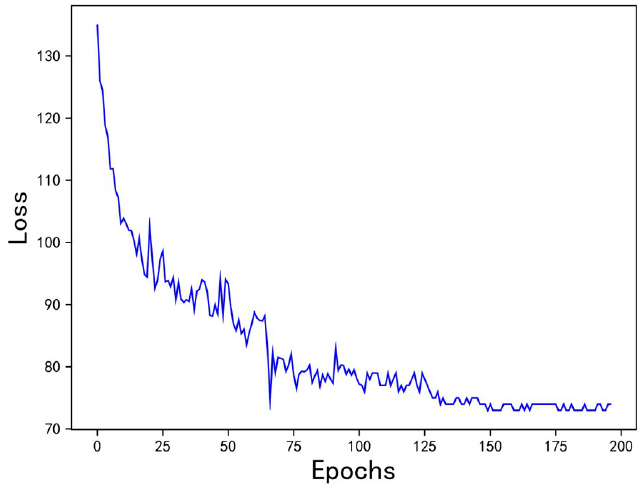
Figure 15. The relationship between Epochs and